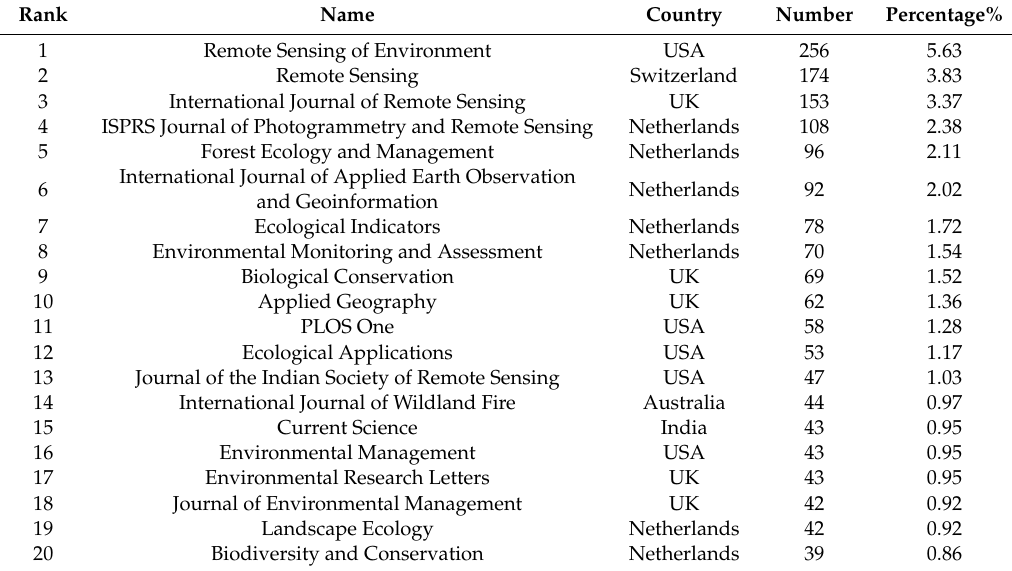
Table 1. Top 20 main source journals in the research